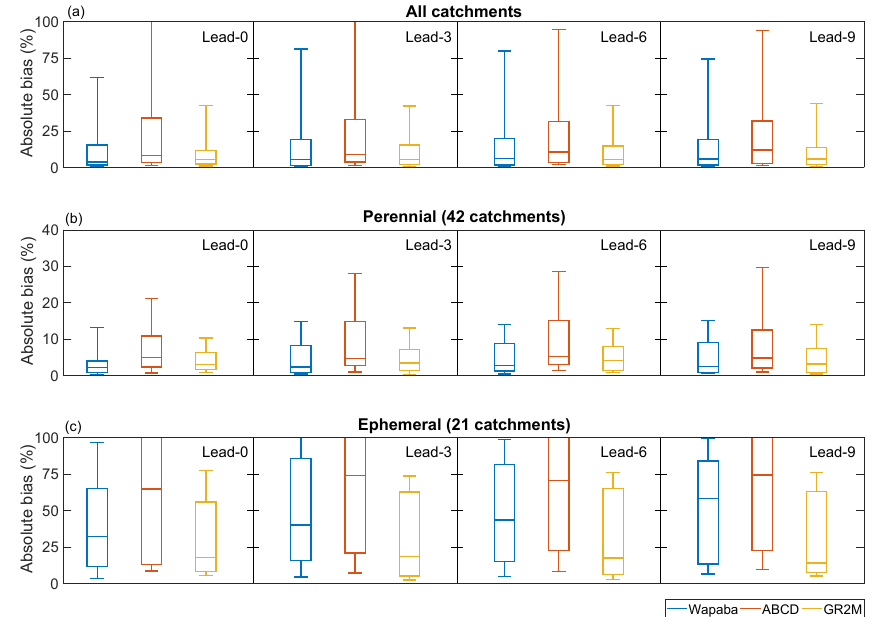
Figure 10. Absolute bias in 63 catchments by lead time for FoGSS forecasts with different rainfall–runoff models. For each lead time absolute bias is summarized for all months with box and whisker plots. Boxes show the interquartile range with the median; whiskers give the 10th and 90th percentiles. (a) shows all catchments, (b) shows perennial catchments, and (c) shows ephemeral